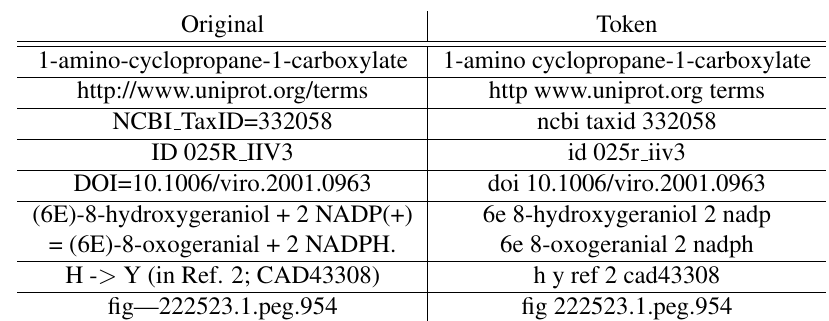
Table 1: Working method of the Apache Lucene StandardAnalyzer shown by typical examples from the area of life science. Left shows the orignal phrases and right showes the decomposed phrases by Apache